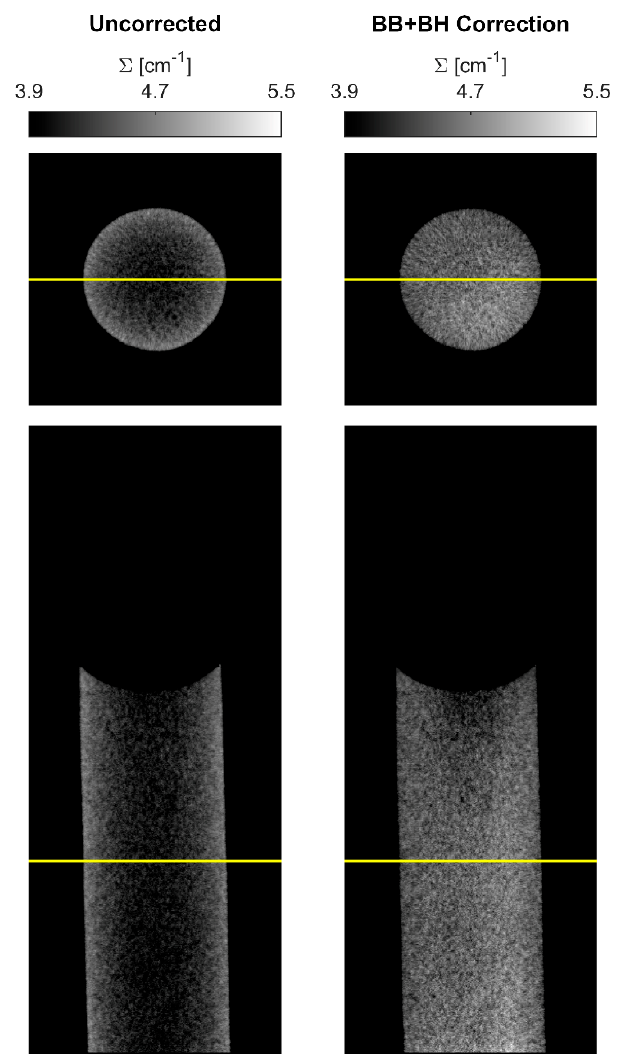
Figure 16. Slices of the water column CT reconstructions. Uncorrected CT shows significant cupping artifacts due to scattering and beam hardening. Combined BB and BH corrections (assuming τ dot = 0% and 2.75 Å Maxwell–Boltzmann spectrum) effectively flatten the attenuation coefficient.